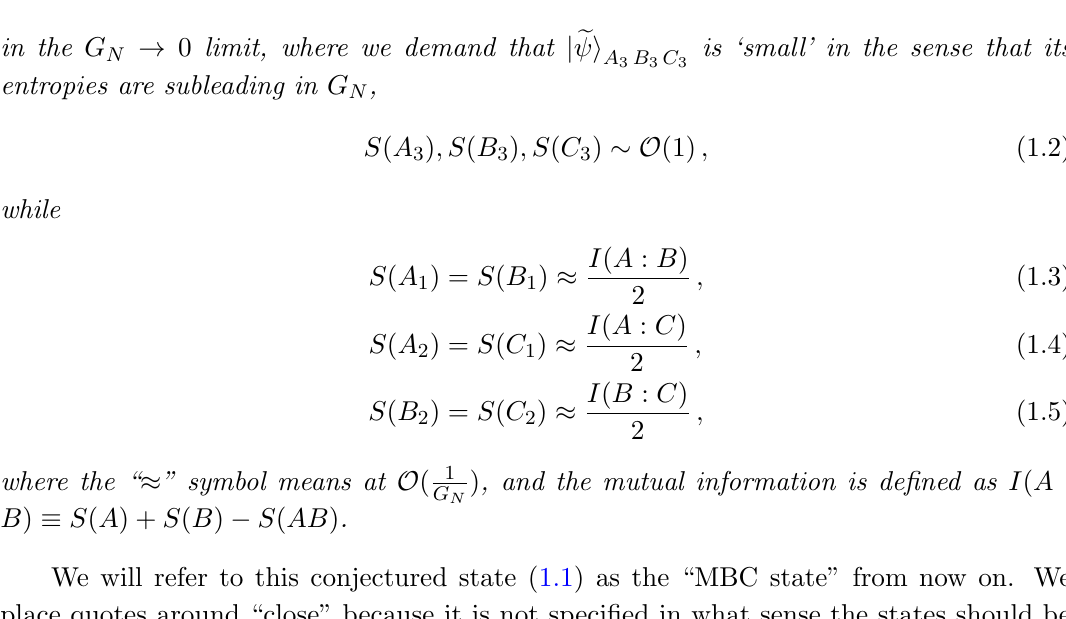
Figure 1 . The entanglement wedge of boundary subregion AB is shaded blue, while the com- plementary entanglement wedge, corresponding to boundary subregion C , is shaded red. The RT surface is (cid:13) AB (solid line), and the minimal cross section of the entanglement wedge is EW ( A : B ) (dashed